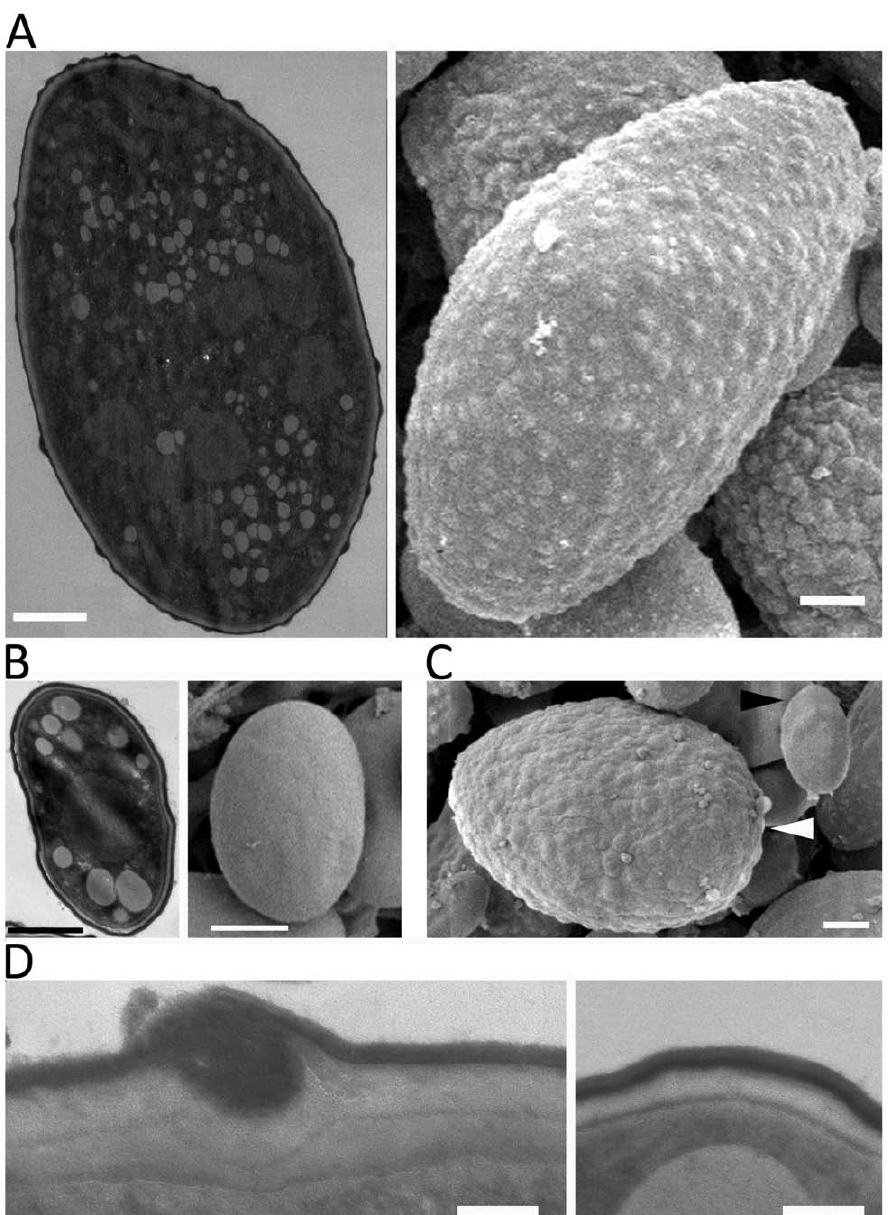
Figure 4. SEM and TEM images of large and small spores. (A) Large spores are decorated with ‘bumps’ on their surface. (B) The surface of small spores is smooth. (C) The subpopulation of small spores in the larger spore producing isolates (CBS277.49) has a smooth surface (black arrowhead) compared to larger spores (white arrowhead). (D) Trafficking to the cell wall is observed in the large spores (left) but not in the small spore (right) indicating that the larger spores may be metabolically active for further development, such as, invasive hyphal growth. Scales are 1 m m for A, B, and C, and 100 nm for D.